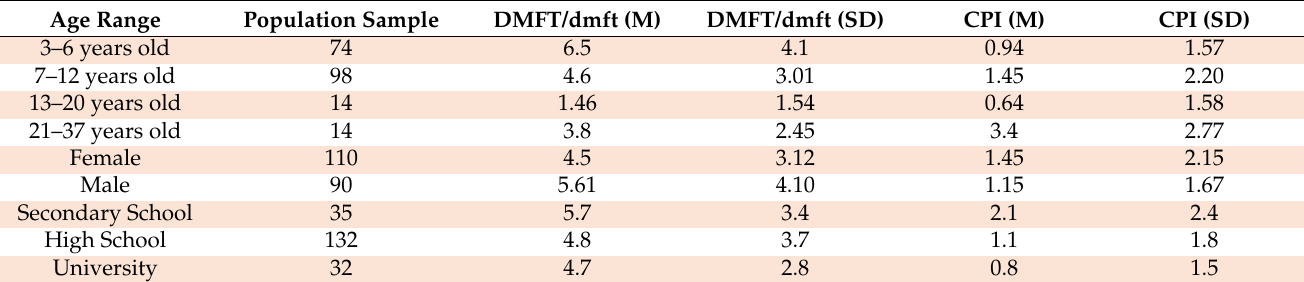
Table 3. DMFT/dmft Index and CPI: Mean (M) and Standard Deviation (SD) according to Age, Sex, and Education Level.